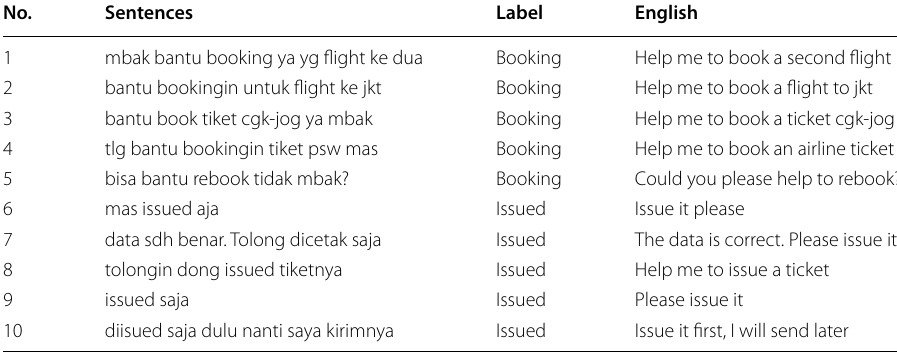
Table 2 The sample of sentences to be classified No.